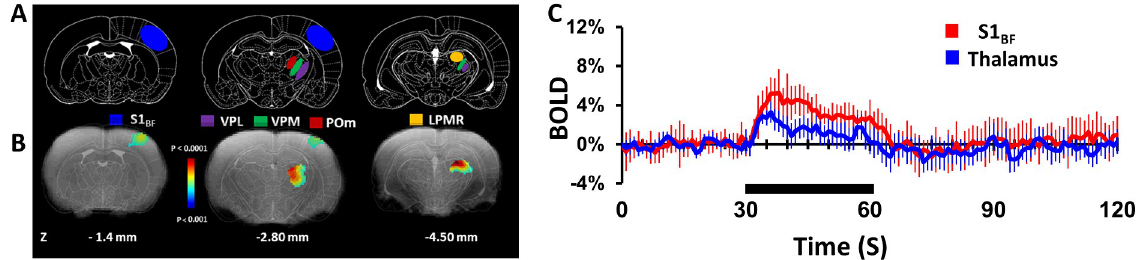
Fig 2. Whisker stimulation-induced activation of rat somatosensory cortex and thalamus revealed by high-field (11.7T) fMRI (8 rats, 22 trials). Significant contralateral BOLD activations were observed at the primary somatosensory barrel cortex (S1 BF ) and thalamic activations were found in different parts of ventral posterior lateral (VPL), ventral posterior medial (VPM), lateral posterior thalamic nucleus mediorostral (LPMR) and posterior medial (POm) during left whisker stimulation by air puff (22 whiskers, 2 mm, 3 Hz). BOLD activation maps, displayed as colored statistical maps (a 2-sample, unpaired, T-test with equal variance and one tail for stimulation (30s) > baseline (30s)) overlaid on the corresponding anatomical images. A and B represents coronal slices corresponding to cortical and thalamic regions positioned at 1.4 mm posterior to bregma for S1 BF , 2.80 and 4.50 mm posterior to bregma for VPL, VPM and LPMR regions. To correlate activations in cortical and thalamic regions, reference stereotaxic atlas images were overlaid on the corresponding anatomical images. C represents the mean ± SD time course of BOLD activations at S1 BF and thalamic regions (VPL, VPM, LPMR and POm).